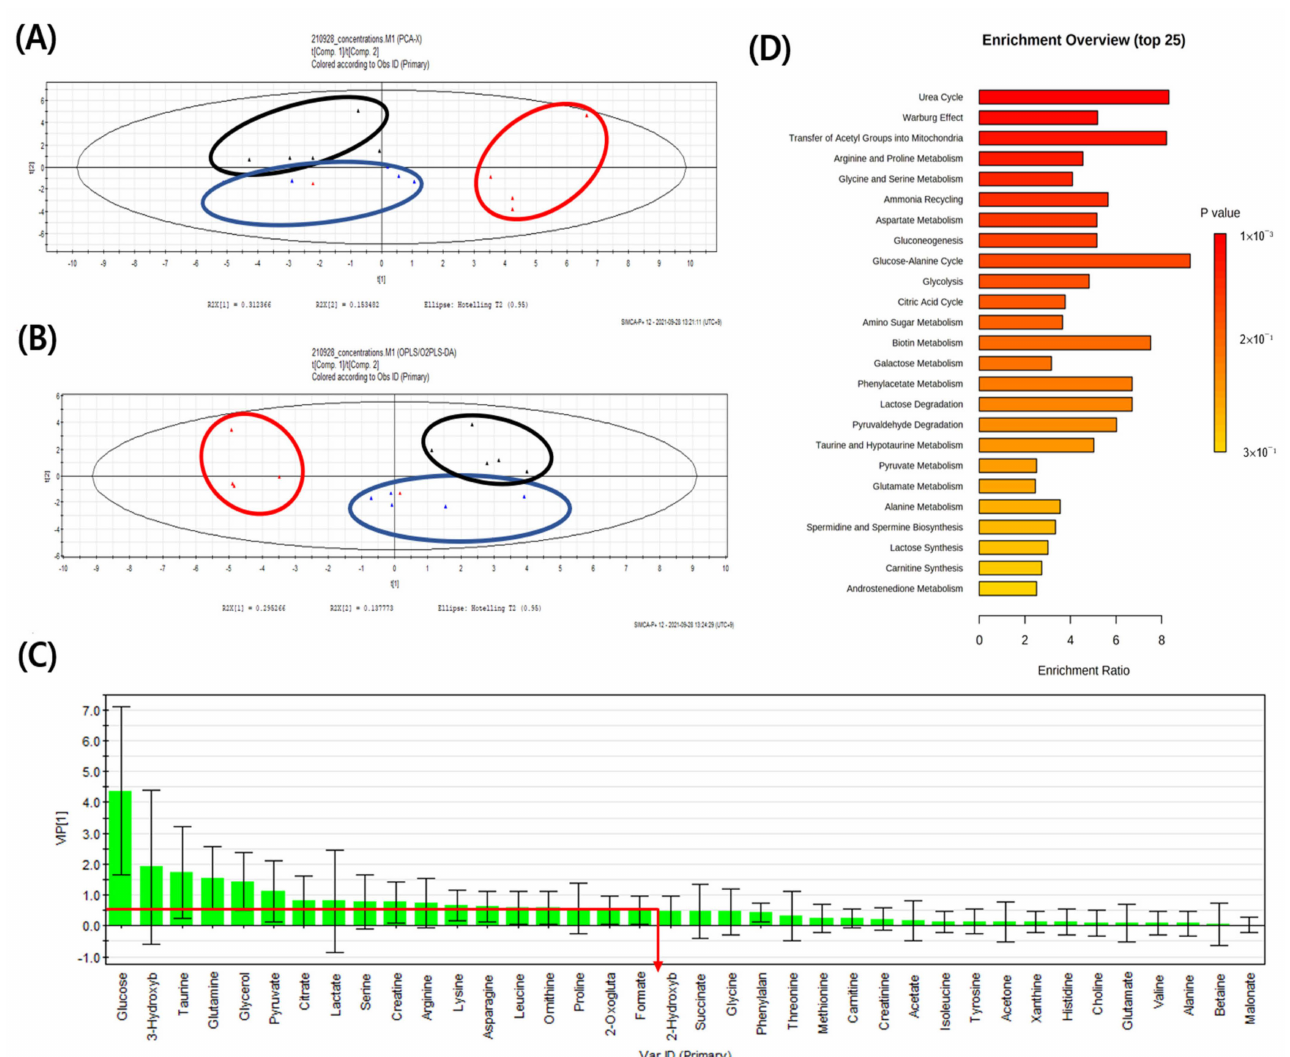
Figure 3. A comparison of metabolite patterns of serum using 1 H-NMR spectroscopy. ( A ) Principal component analysis (PCA) (R 2 X = 1, Q 2 = 0.999) and ( B ) orthogonal projections to latent structures- discriminant analysis (OPLS-DA) (R 2 X = 0.707, Q 2 = 0.478) models results after NMR analysis of control, positive control, and test group in serum samples. ( C ) Variable importance plot (VIP) shows the major serum metabolites that contributed to separate the clusters (VIP ≥ 0.5) and ( D ) Metabolites set enrichment overview ( n = 5); (cid:78) , control (CON); , positive control (PC); , test